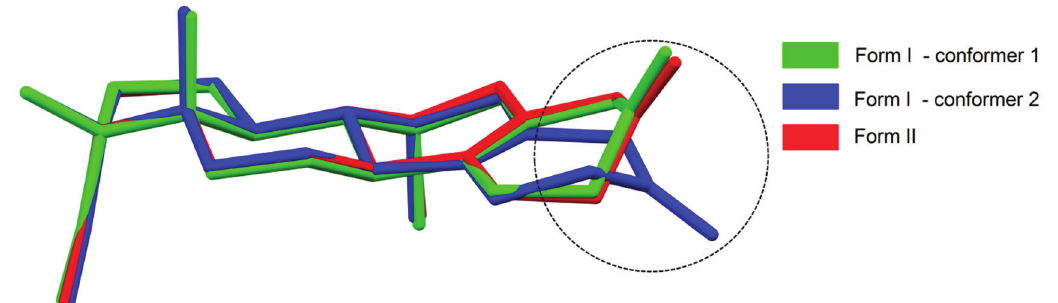
FIGURE 1 – Perspective view showing the superposition of form I (conformers 1 and 2 in green and blue, respectively) and form II (in red) of tibolone. The molecular backbones were generated from the known crystal structures (Declercq, Van Meerssche, Zeelen, 1984; Schouten, Kanters, 1991). The hydrogen atoms were hidden for